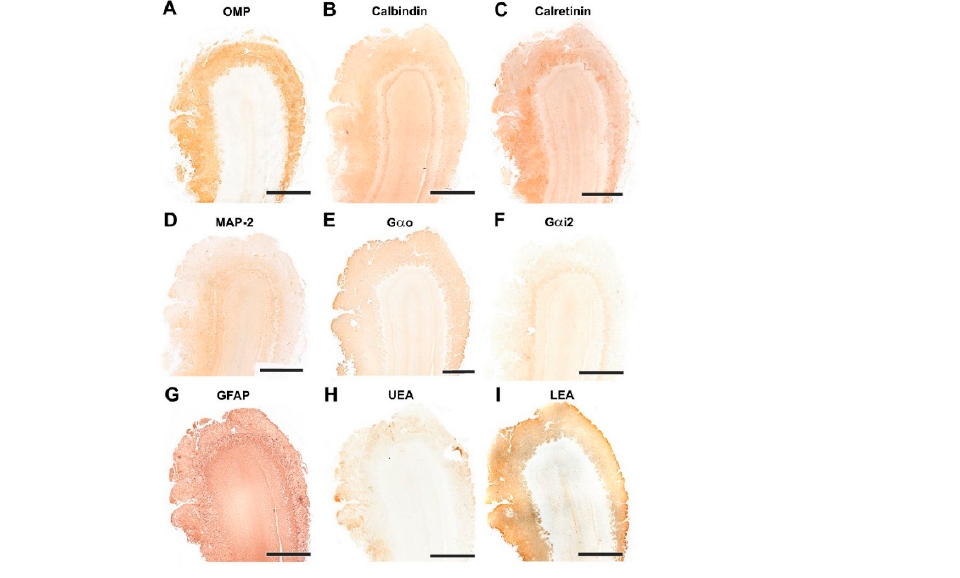
Figure 7. Immunohistochemical and lectin-histochemical study of the OB of the dog. ( A ) Anti-Olfactory marker protein (OMP). ( B ) Anti-Calbindin. ( C ) Anti-Calretinin. ( D ) Anti-MAP-2. ( E ) Anti-Gao. ( F ) Anti-Gai2. ( G ) Anti-GFAP. ( H ) UEA histochemical labeling. ( I ) LEA histochemical labeling. Scale bars: 2 mm.